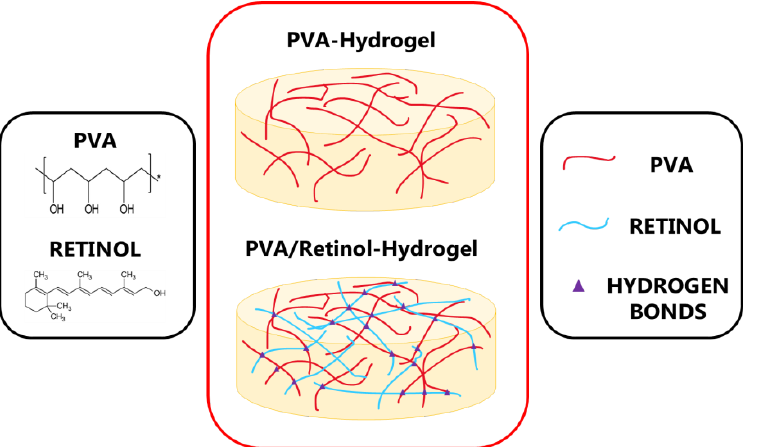
Figure 11. Schematic diagram of the structure of retinol-loaded PVA hydrogels. Purple triangles indicate the possible hydrogen bonding between PVA and retinol molecules.